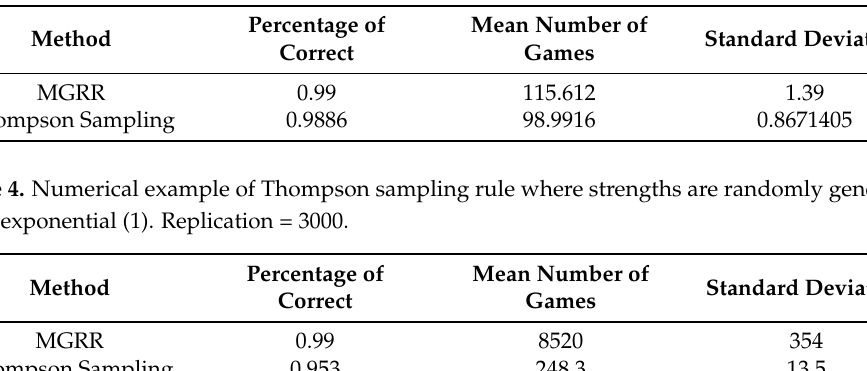
Table 3. Numerical example of Thompson sampling rule where strengths v = (0.3, 0.5, 0.7, 0.9, 1.5). Replication = 5000.